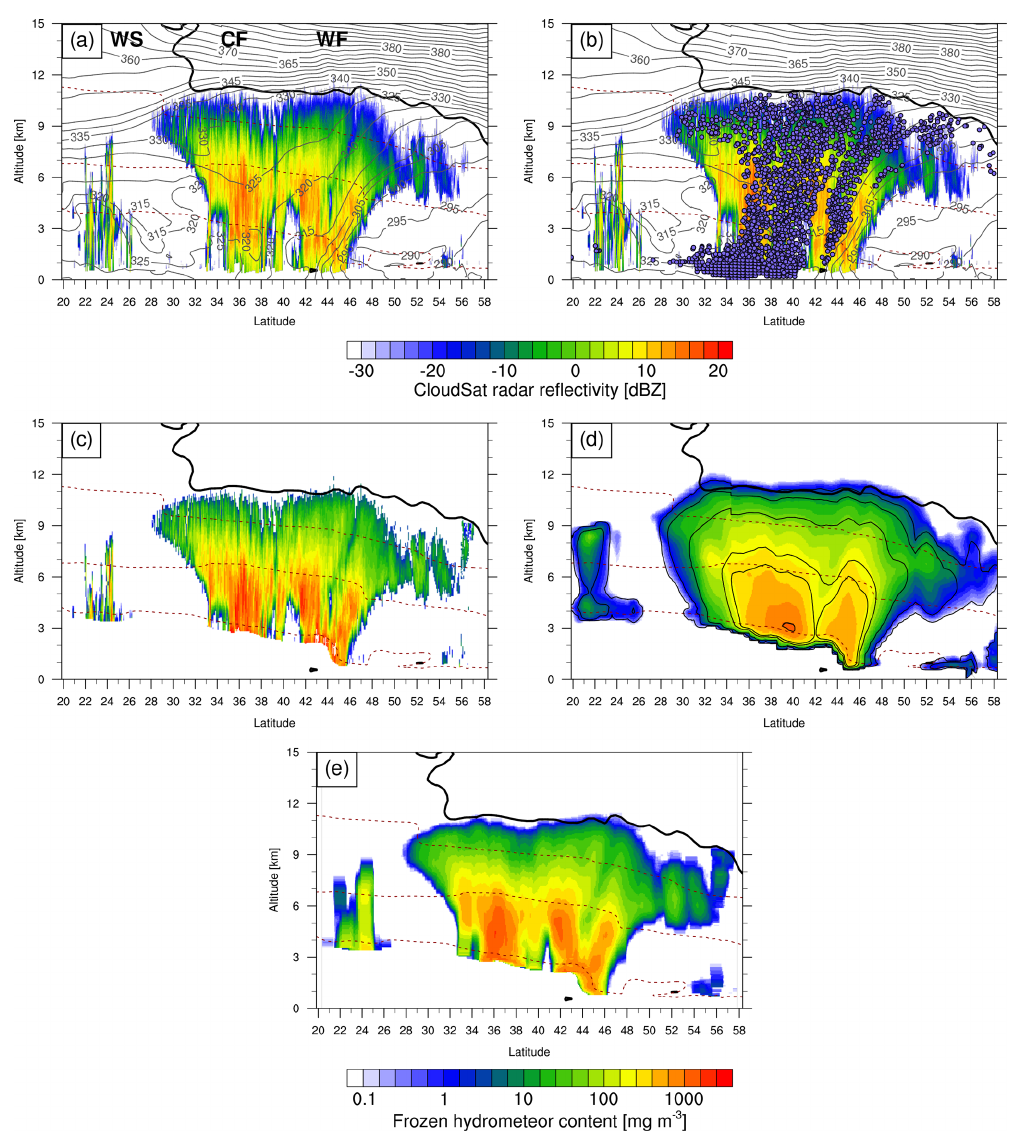
Figure 3. Vertical cross sections of observed and modelled variables along a North Pacific WCB at 00:00UTC on 3 January 2014. (a) Cloud- Sat radar reflectivity (dBZ; shading) along the segment between the two black crosses in Fig. 2b, together with, from ERA5, interpolated θ e (black contours every 5K), temperature (dashed red contours at 0, − 20 and − 40 ◦ C) and the 2pvu contour (thick black line). The labels mark the position of the warm sector (“WS”), the cold front (“CF”) and the warm front (“WF”). (b) Same as (a) but with the positions of the intersected WCB trajectories shown by the purple dots. (c) DARDAR-retrieved IWC (mgm − 3 ; shading), which consists of the entire frozen hydrometeor content, i.e. ice and falling snow, (d) ERA5-based frozen hydrometeor content, i.e. the sum of the prognostic cloud ice and snow water contents (mgm − 3 ; shading), and prognostic snow water content only (thin black contours at 0.1, 1, 10, 100, 200 and 1000mgm − 3 ), and (e) DARDAR-retrieved IWC in a running mean along 113 satellite profiles (corresponding to a segment of ∼ 124km). The thick black line in (c–e) again marks the 2pvu contour, and the dashed red lines mark the 0, − 20 and − 40 ◦ C